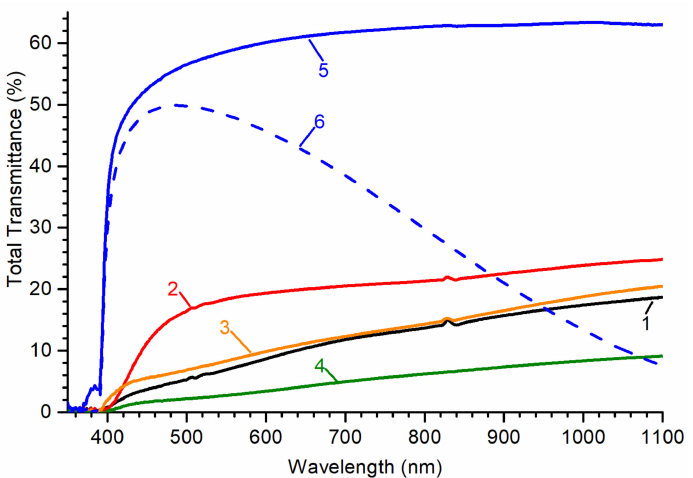
Figure 2. Total transmittance spectra of studied ZnO samples: 1—whiskers; 2—whiskers after annealing in air; 3—nanowalls; 4—multipods; 5—undoped ceramics; 6—ceramics doped with 0.075 wt.% of